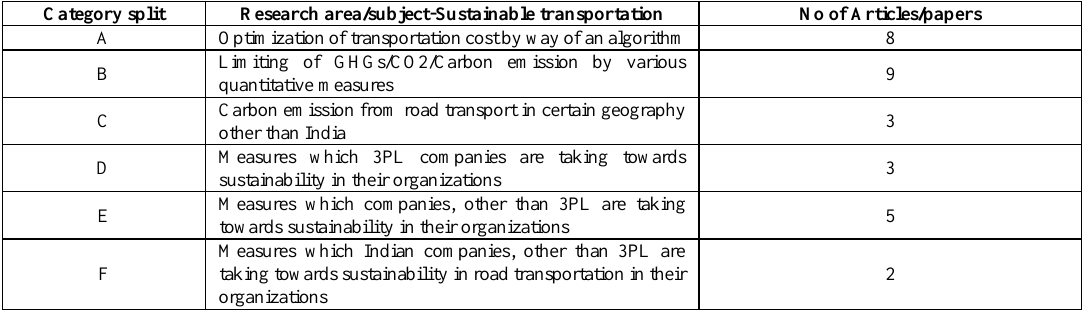
Table 1. Literature review